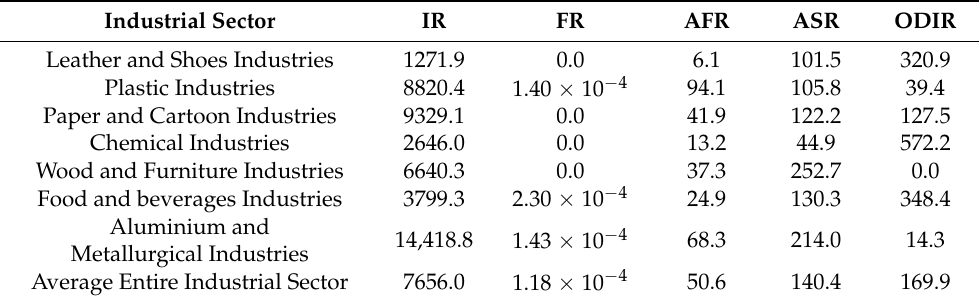
Table 8. Calculated EU-OSHA rates for each industrial sector and the entire industrial sector for